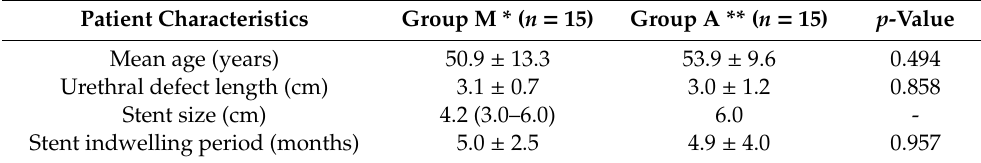
Table 1. A summary of baseline clinical characteristics of patients in both